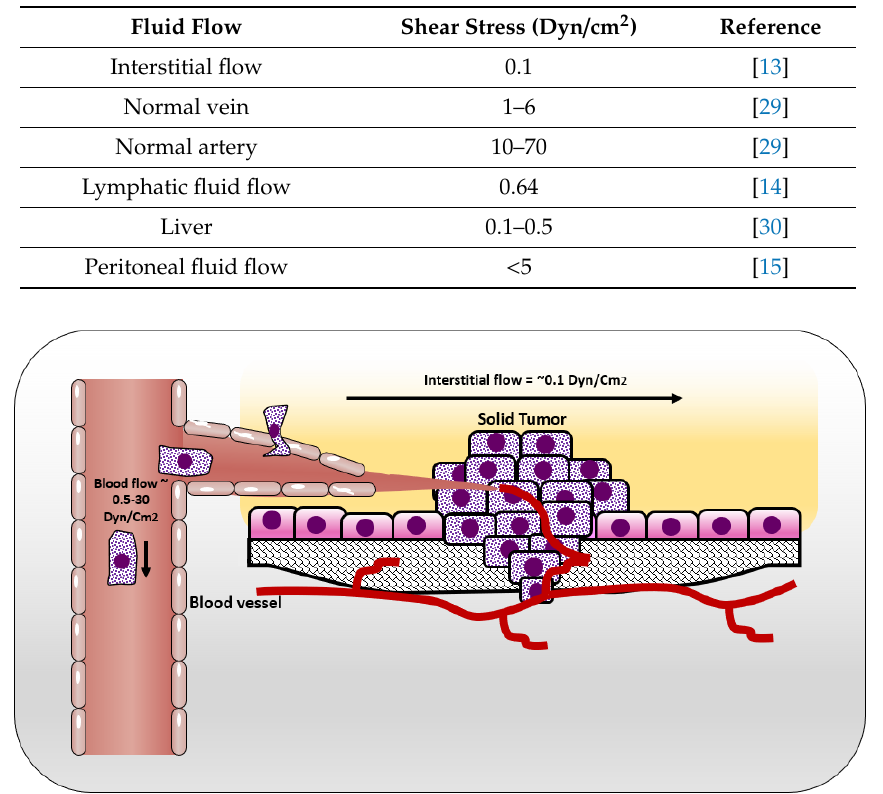
Table 1. Di ff erent shear rate values in physiological and pathological conditions.